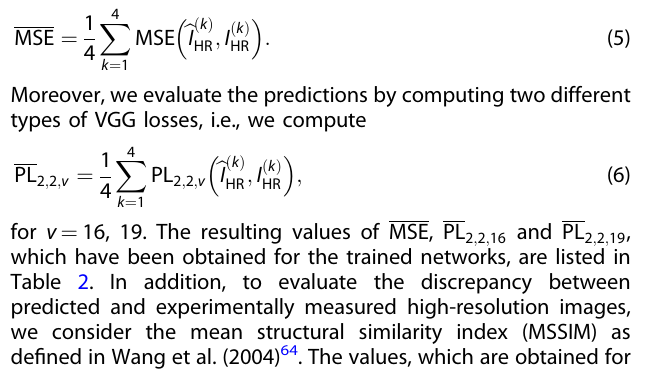
Table 2. In addition, to evaluate the discrepancy between predicted and experimentally measured high-resolution images, we consider the mean structural similarity index (MSSIM) as de fi ned in Wang et al. (2004) 64 . The values, which are obtained for